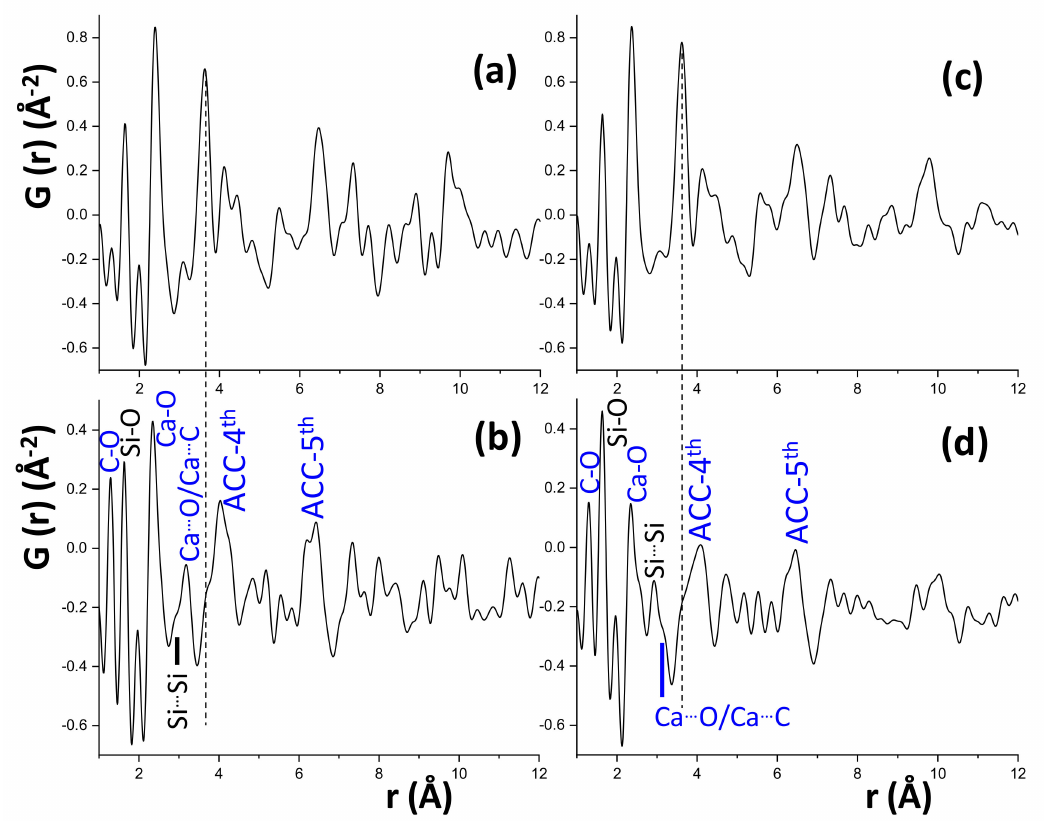
Figure 8. Low r-range differential PDF patterns for ( a ) C 3 S_hyd, ( b ) C 3 S_carb, ( c ) C 2 S_hyd and ( d ) C 2 S_carb. These traces display the difference between the raw PDFs patterns and the calculated contributions from the crystalline contents through the fits to the high r-range region as displayed in Figure 7. Therefore, these are the contributions of the nanocrystalline and amorphous phase contents. Prominent peaks due to amorphous silica (black) and amorphous calcium carbonate (blue) are labelled for the carbonated